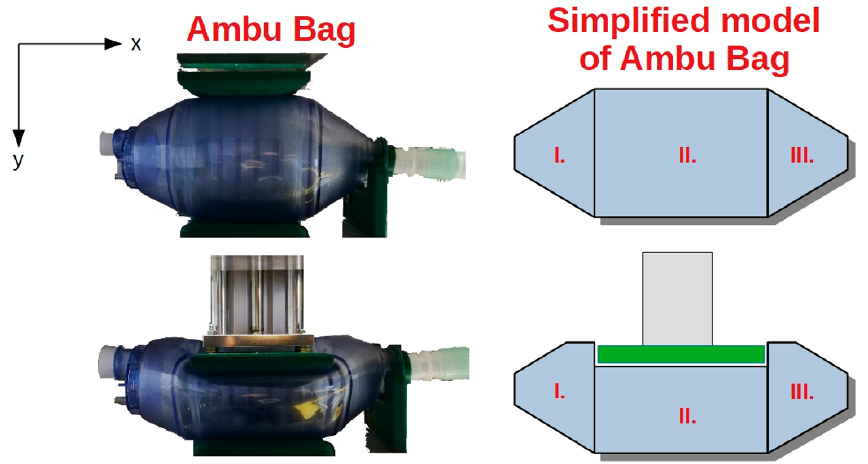
Figure 16. Simplified model of AmbuBag. Individual images are as follows. Top left: real AmbuBag before compression, Bottom left: real AmbuBag after compression. Top right: Simplified model of AmbuBag before compression, Bottom right: Simplified model of AmbuBag after compression.